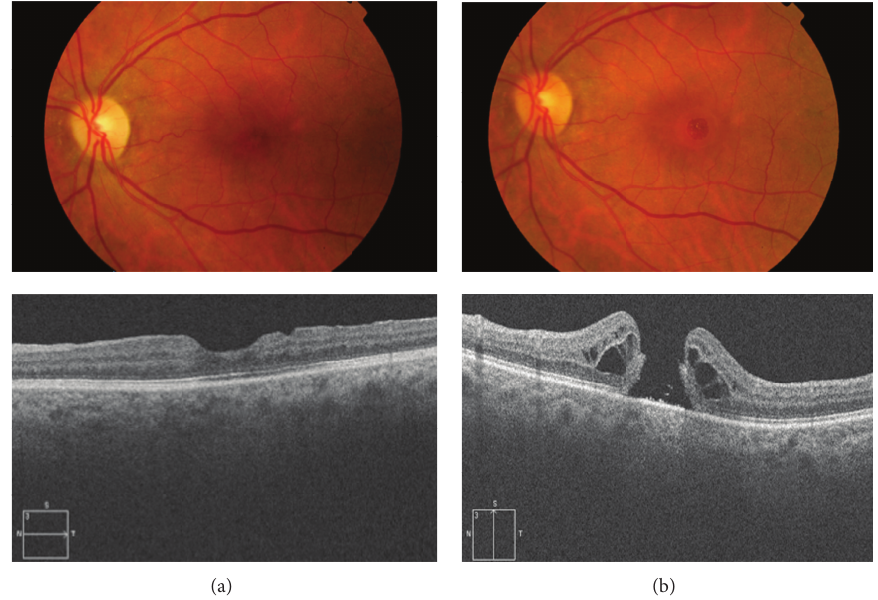
Figure 4: (a) Fundus photography and OCT of a patient who underwent macular hole surgery with ILM peeling and adequate reconstitution of the outer retina (ELM and ellipsoid bands) and visual acuity 20/30. (b) Reopening of the MH after 3 years with cystoid edema surrounding the hole and decreased visual acuity to 20/200. The ERM is not observed.